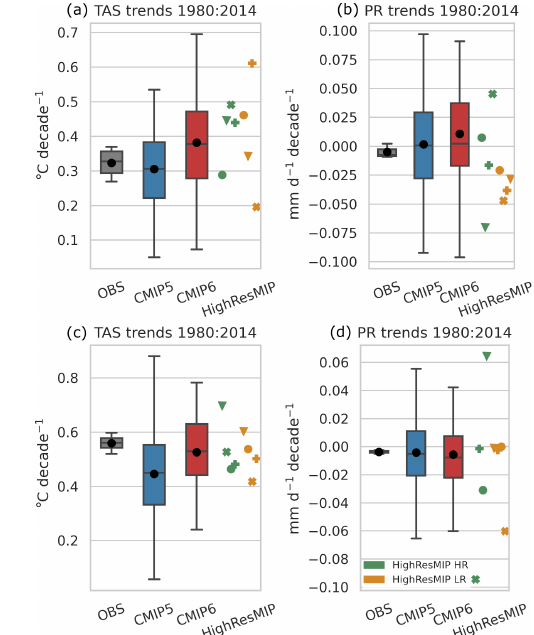
Figure 1. Historical trends for DJF (a,b) and JJA (c,d) temper- ature (a,c) and precipitation (b,d) of the observational, CMIP5, CMIP6 and HighResMIP ensembles. The observational distribution is composed of the different values obtained from each of the ob- servational products. In the box plots, the black horizontal line rep- resents the median and the black dot is the mean. The interquartilic range (IQR) and whiskers are defined by the 25th–75th and 5th– 95th percentiles respectively. HighResMIP models are displayed as markers, enabling a comparison of the HR (green) and LR (orange) models within the experiment. The same markers are used for two different resolution runs of the same model (see Table S1 in the